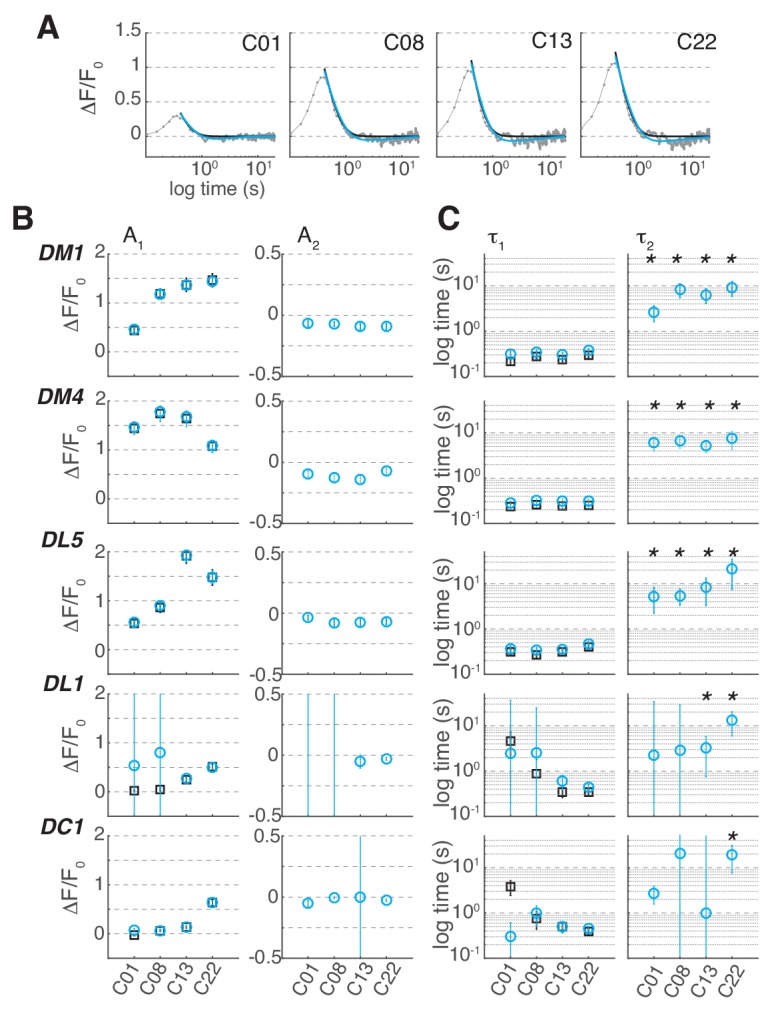
Linear filters for Syp-pHTomato signal from ORN terminals.(A) Linear filter (gray) for the Syp-pHTomato signal in glomerulus DM1 at different odorant concentrations and corresponding fit with either a single (black, k1t=A1e-tτ1) or a double (cyan,k3t=A1e-tτ1+A2e-tτ2) exponential. (B) Amplitude of single (black) and double (cyan) exponential fit to the linear filter as a function of stimulus concentration in 5 glomeruli. A1 represents the amplitude of the first exponential. A2 represents the amplitude of the second exponential. Error bars indicate 95% confidence intervals. (C) Timescales of the first, τ1, and second, τ2, exponential. Error bars indicate 95% confidence intervals. Stars indicate conditions where a double exponential fits the data better than a single exponential (BIC < 0, see Materials and methods). The response of DL1 to C01 and C08 and the response of DC1 to C01, C08 and C13 are too weak to fit a model.